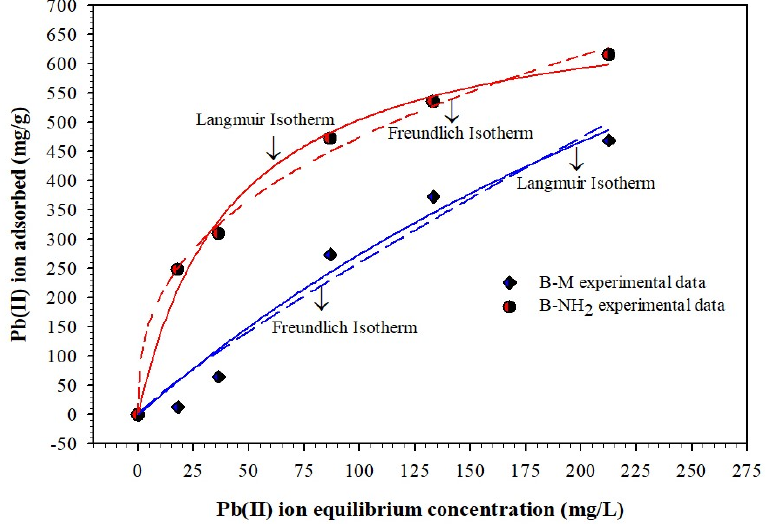
Figure 6. Isotherm study of Pb(II) ion adsorption by B-M and B-MNH 2 . Reaction conditions: an adsorbent mass of 60 mg, a sample volume of 200 mL, a pH of 5, and a shaking rate of 150 rpm.